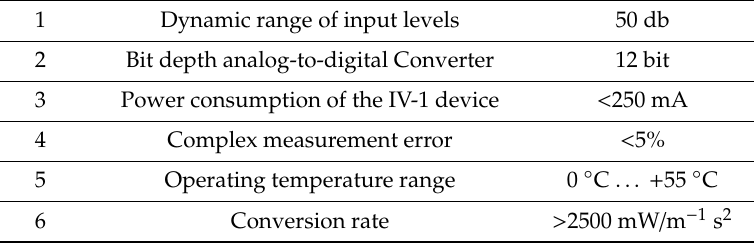
Table 1. main characteristics of the vibration measuring device.